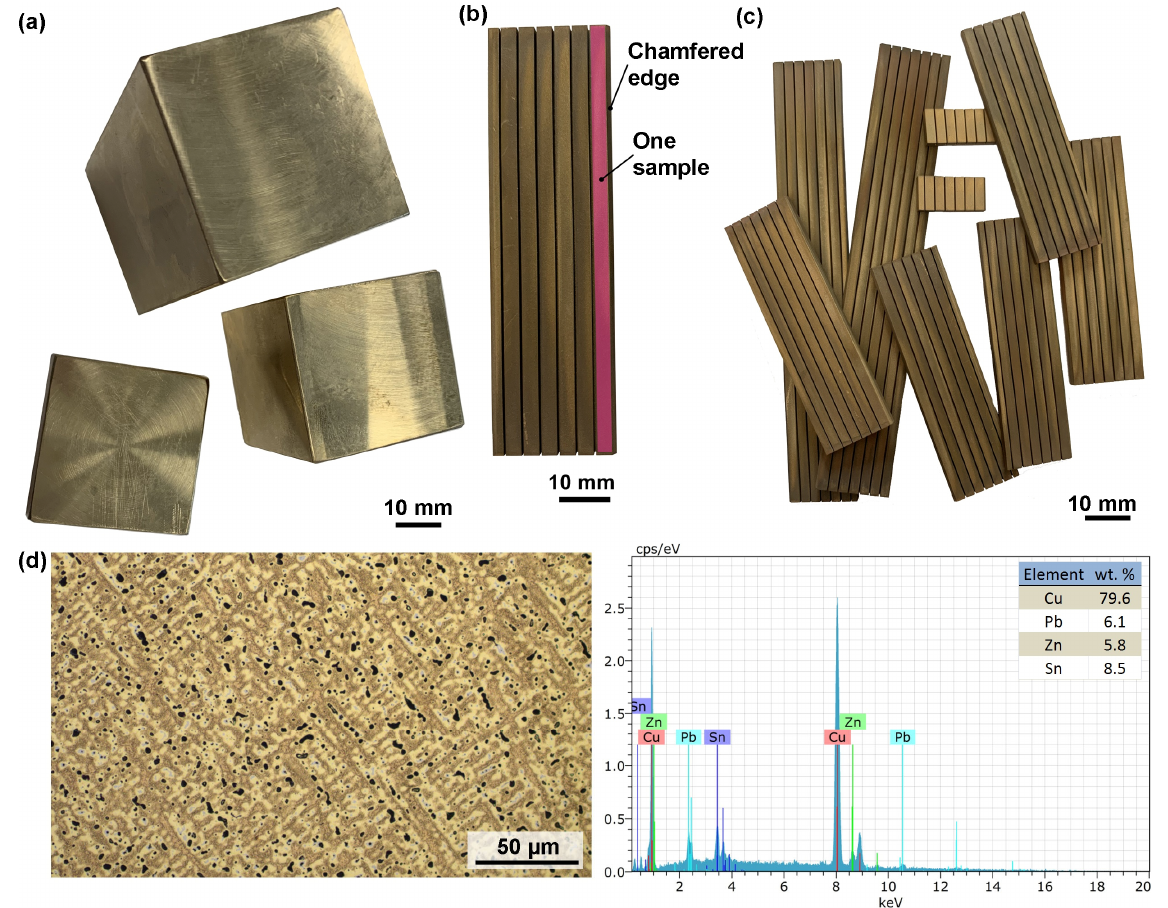
Figure 1. ( a ) Example of semifinished products for sample production, ( b ) example of a produced plate with 6 samples, ( c ) example of produced plates, ( d ) microstructure and EDX